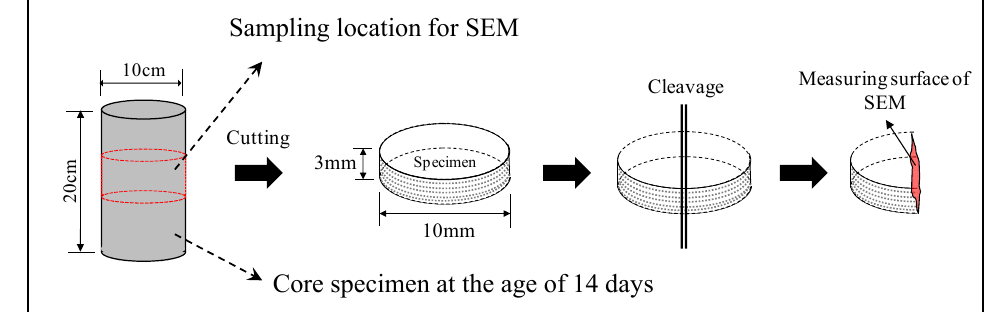
Figure 7. Sampling of a specimen for scanning electron microscopy (SEM).